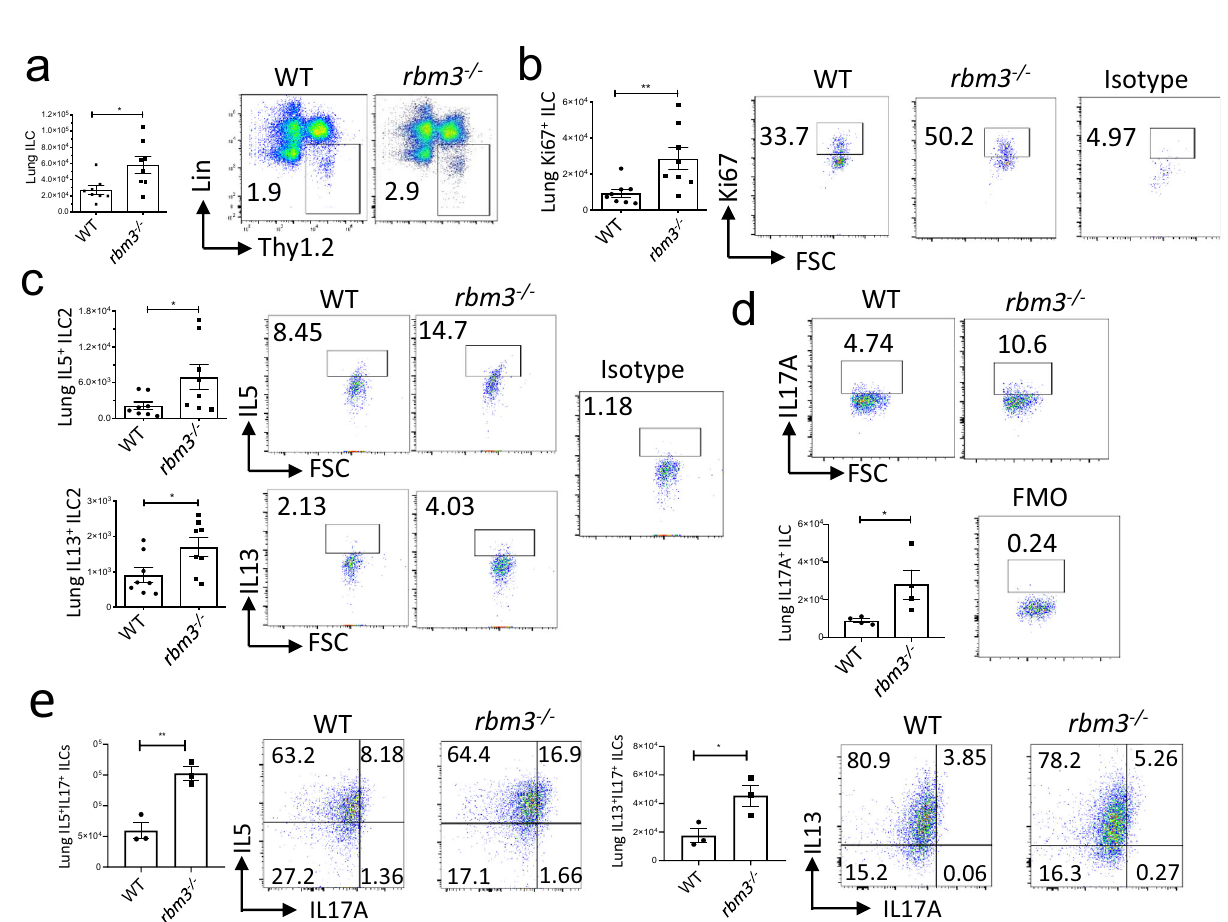
Fig. 2 | Alternaria- challenged Rbm3 − / − mice exhibit signi fi cant increases in air- waygranulocytes,in fl ammation,andTh2cytokines. Wild-typeand Rbm3 − / − mice were challenged with 10 µ g Alternaria three times over 7 days. Data shown are representative of 3 experiments (4 mice per group). a Total BAL ( p =0.0036) and lung eosinophils ( p =0.0083). Representative FACS plots of WT and Rbm3 − / − mice. Mann-Whitney Test, two-tailed. b Total BAL (p=0.0001) and lung ( p =0.0001) neutrophils.RepresentativeFACSplotsofWTand Rbm3 − / − mice.Statisticsanalyzed by Mann-Whitney Test, two-tailed. Wild-type and Rbm3 − / − mice were challenged